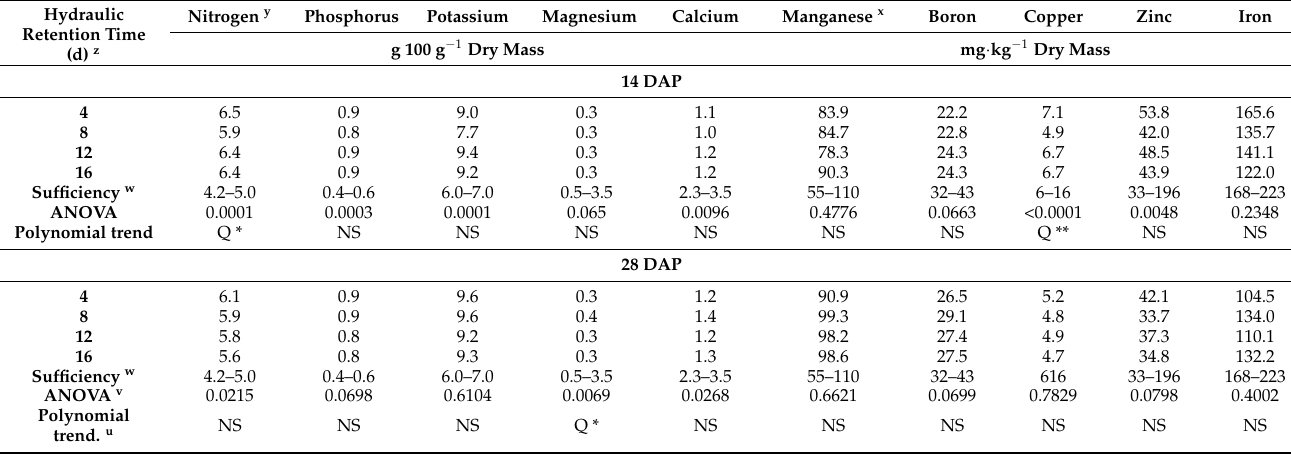
Table 8. Foliar analysis of ‘Rex’ butterhead lettuce ( Lactuca sativa ) HRT with iron supplementation, simple effects of HRT for each week